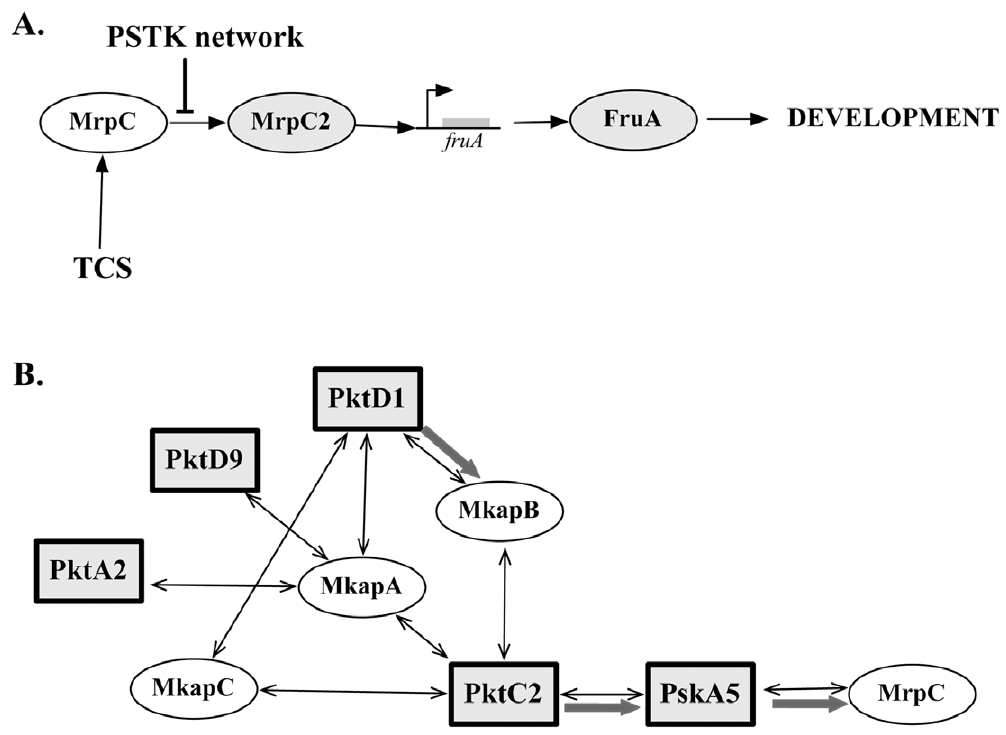
Figure 1. Regulatory network model of development in Myxococcusxanthus . A. Regulatory network model of fruA expression. Expression of fruA is a key step in the induction of developmental gene expression and the achievement of multicellular fruiting body formation and sporulation. During vegetative growth, mrpC is transcribed at low levels, using its own product (MrpC) as a transcription factor (positive feedback). When starvation signals trigger the expression of genes in a two component system (TCS) the newly synthesized MrpC is not phosphorylated, but is instead processed to MrpC2, which has a higher affinity for the mrpC and fruA promoter regions [34]. A PSTK network inhibits development by phosphorylating MrpC. B. The Protein Serine-Threonine Kinase (PSTK) network model. PSTK network is thought to consist of at least five kinases (squares) as well as three multikinase associated proteins (Mkaps). Double-headed arrows indicate interactions identified by yeast-two hybrid screens, while gray arrows are characterized phosphorylation pathways [35]. PskA5, a protein kinase activated by PktC2, phosphorylates MrpC, reducing its affinity for both mrpC and fruA promoter regions, and preventing untimely initiation of development. In this paper, PktA2, C2, D1 and D9 were deletion targets. The pskA5 locus is closely linked to that of mrpC / mrpC2 and therefore was not a candidate for in-frame deletion.